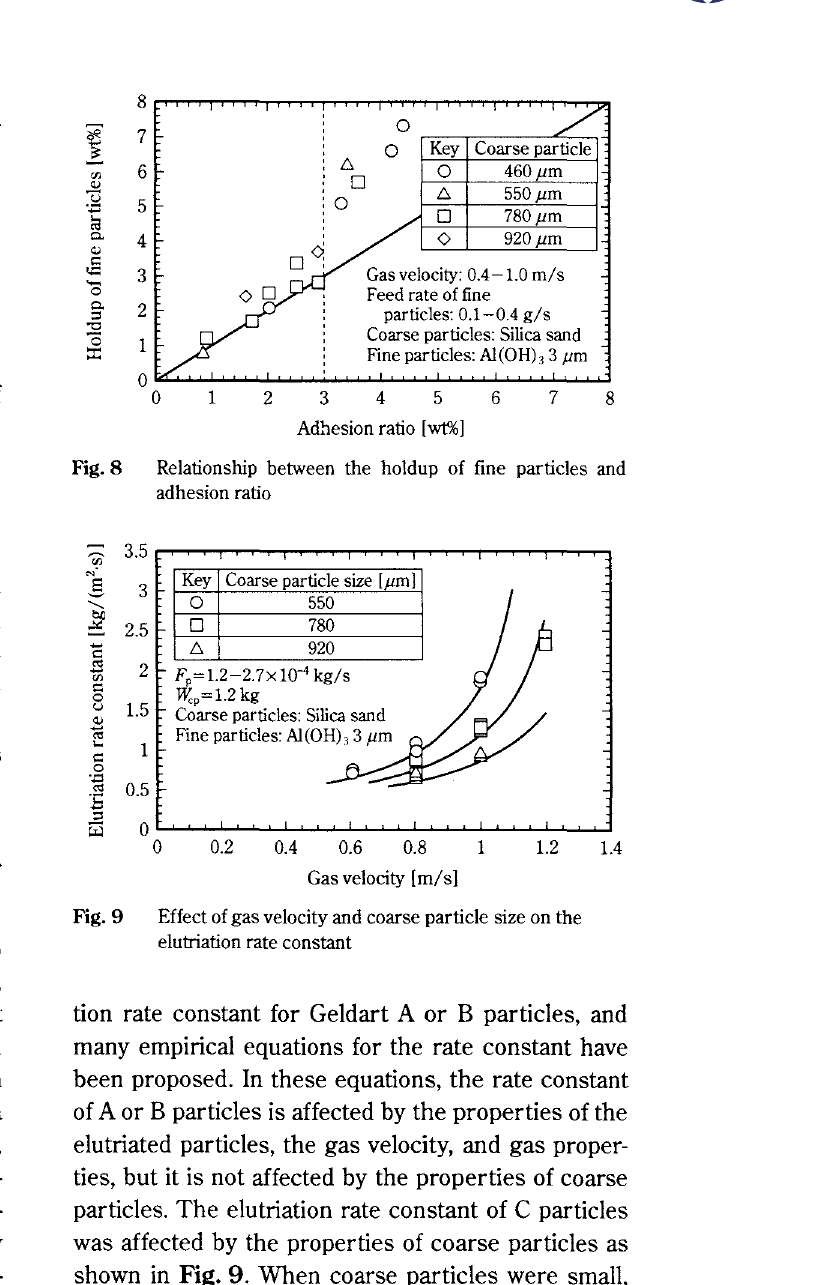
1.4 Fig. 9 Effect of gas velocity and coarse particle size on the elutriation rate constant tion rate constant for Geldart A or B particles, and many empirical equations for the rate constant have been proposed. In these equations, the rate constant of A or B particles is affected by the properties of the elutriated particles, the gas velocity, and gas proper ties, but it is not affected by the properties of coarse particles. The elutriation rate constant of C particles was affected by the properties of coarse particles as shown in Fig. 9. When coarse particles were small, the minimum fluidization gas velocity is small and the fluidization intensity U-Umt increased at a constant gas velocity. The separation rate of fine particles from coarse particles increased, as did the rate constant of fine particles. Fig. 10 shows the effect of superficial gas velocity on the elutriation rate constant, with the size of fine particles as a parameter. When the size of the parti cles elutriated was small, the rate constant decreased considerably as shown in Fig. 10. This tendency is quite different from the elutriation rate constant for Gel dart A or B particles. The elutriation rate constant of particles at a constant superficial gas velocity attained the maximum value at the boundary between Geldart A particles and Geldart C particles [11].